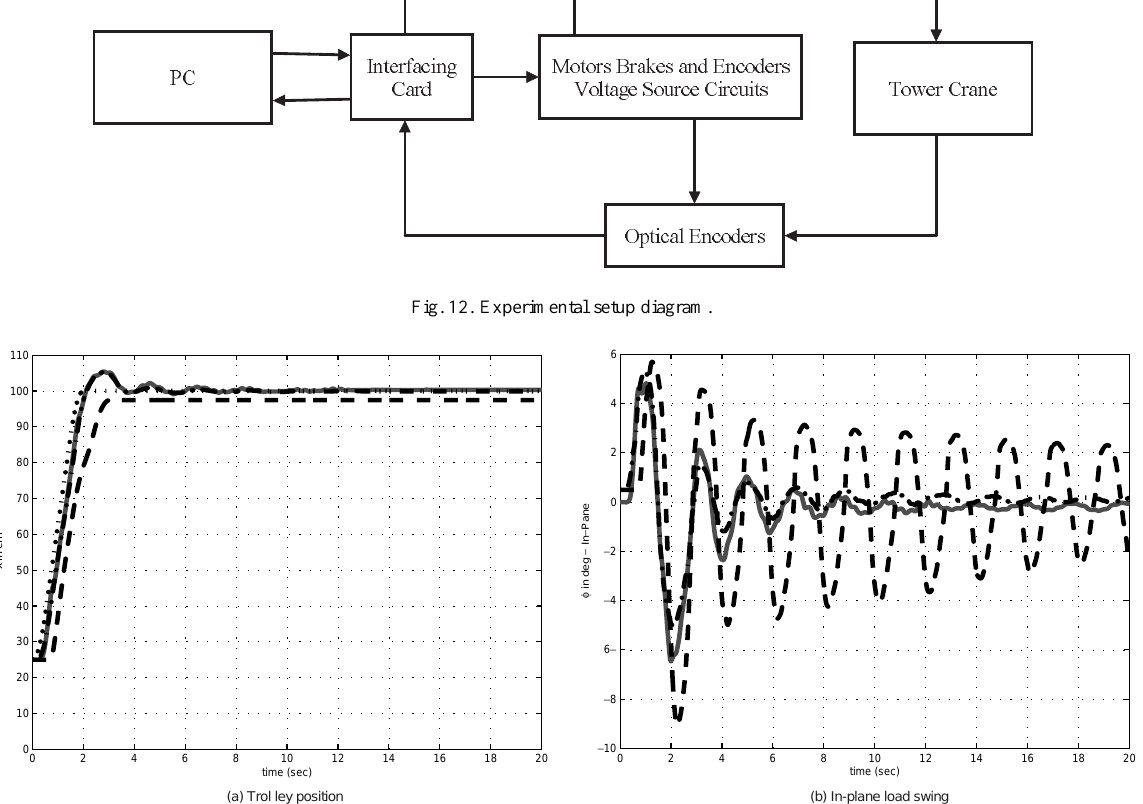
Fig. 13. Time histories of the translational motion: —— fuzzy with friction compensation, - - - - fuzzy without friction compensation, -.-.-.- delay with friction compensation, and . . . . . reference